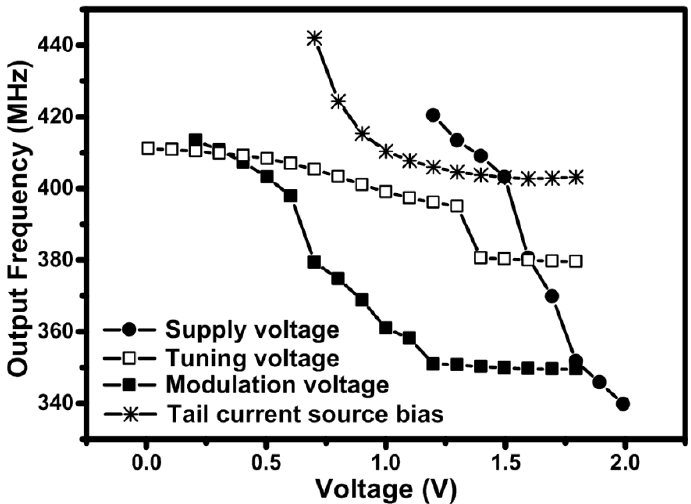
Figure 15. Measured output frequency of oscillation of the 433 MHz design as a function the supply voltage, tuning voltage, modulation voltage and tail current source bias. During the sweep of one bias voltage, the other three were kept constant at 1.5 V, except for the tuning voltage and modulation voltage, which were kept constant at 0.5